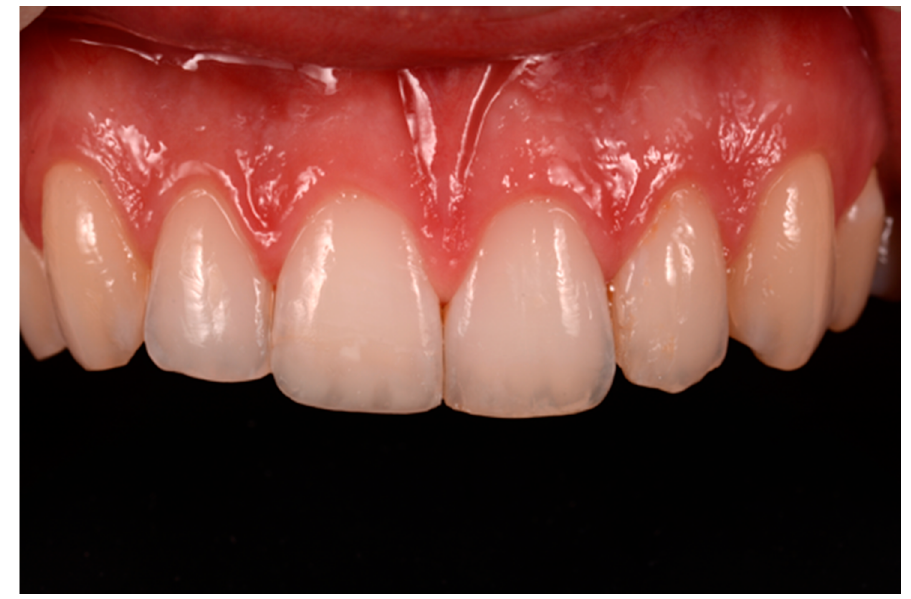
Figure 57. One-year